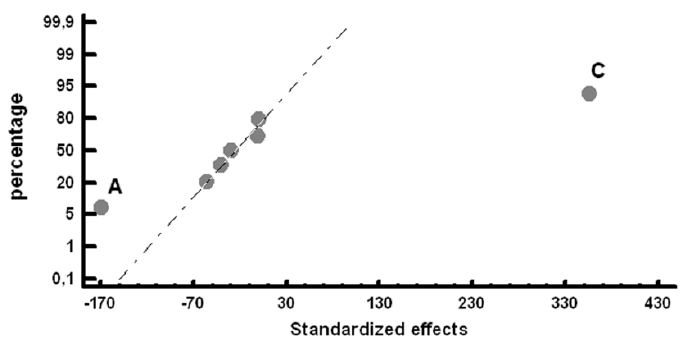
Figure 1. Standardized effects on the overall hardness, on a normal probability plot.